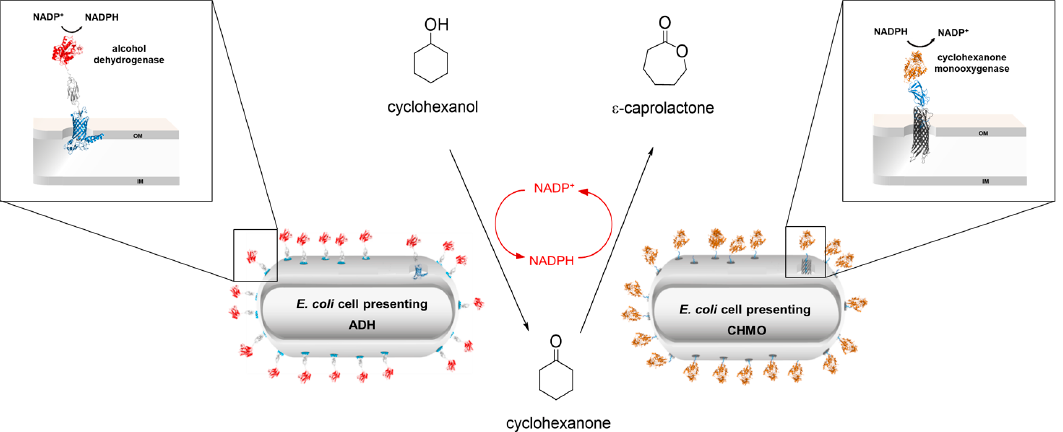
Figure 32. Conversion of cyclohexanol to ε -caprolactone with E. coli cells displaying the ADH and E. coli cells displaying the CHMO. The ADH oxidizes cyclohexanol with the cofactor NADP+, resulting in the products cyclohexanone and NADPH. These are then converted by the CHMO into ε -caprolactone and NADP+.